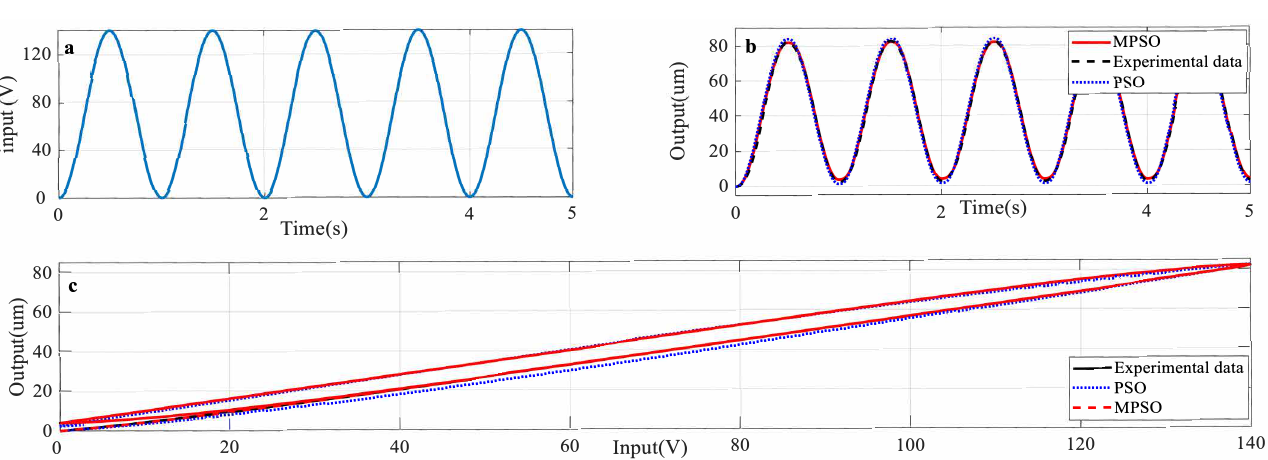
Figure 7. ( a ) Input excitation to the piezoelectric actuator (PEA) actuator, ( b ) predicted and measured output results, ( c ) hysteresis output predicted and measured results.